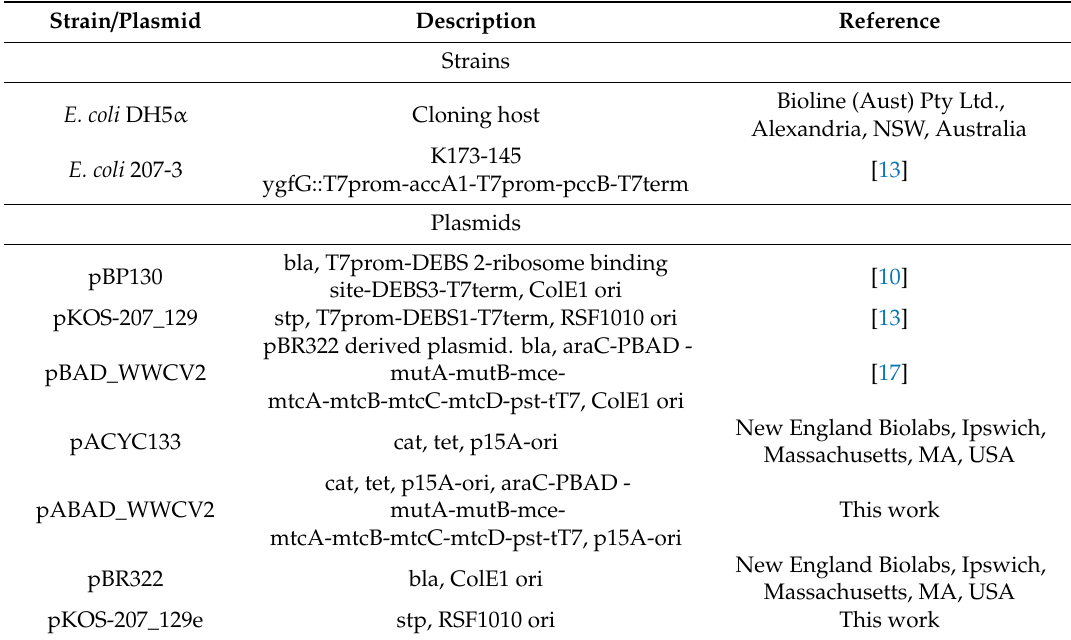
Table 2. Bacterial strains and plasmids